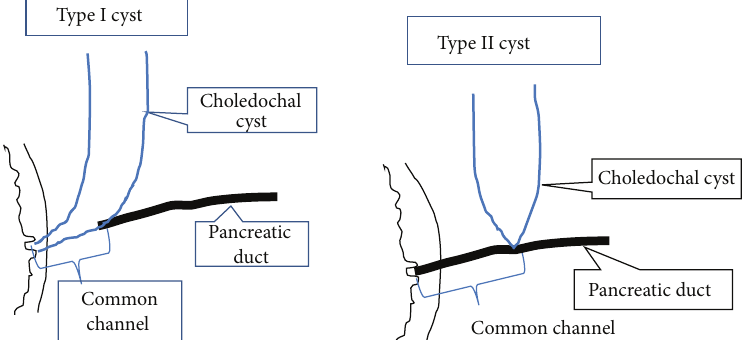
Figure 6: Types of abnormal union of pancreaticobiliary junction. Type I cyst (PC junction)—main pancreatic duct joins the common bile duct. Type II cyst (CP junction)—the common bile duct enters the main pancreatic